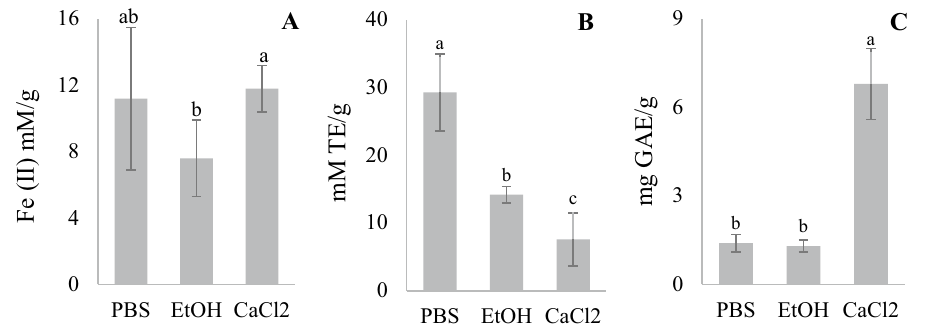
Figure 1. Solvent impact on fresh frozen spirulina antioxidant system activity detected by ( A ) FRAP, ( B ) ABTS, ( C ) TPC. Results expressed as ( A ) mean value ± SD Fe(II) mM/g; ( B ) mean value ± SD mM TE/g; ( C ) mean value ± SD mg GAE/g. The different letters represent significant differences at p <